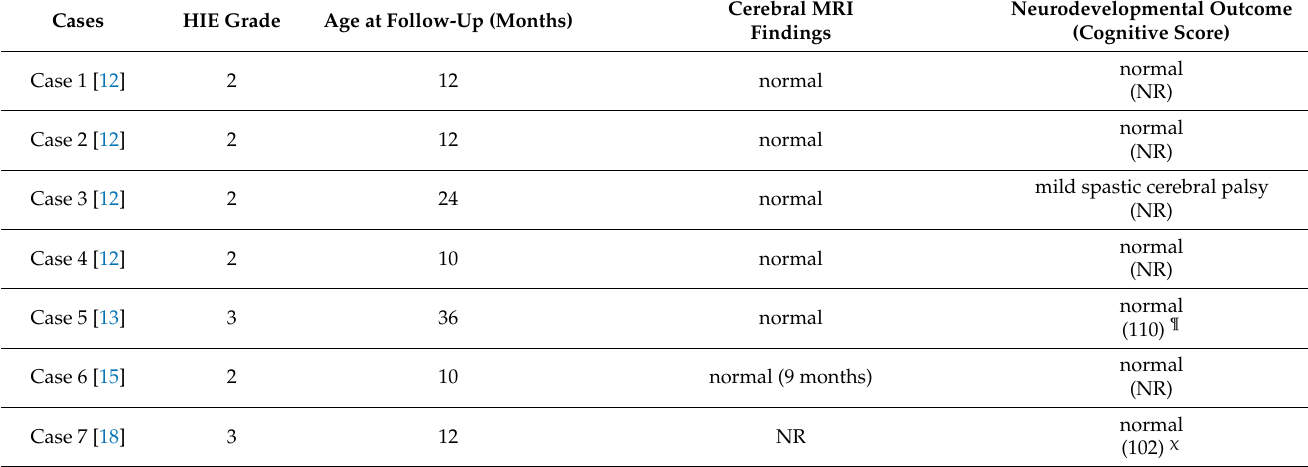
Table 3. Characteristics of infants with SUPC treated with TH and with complete neurodevelopmental follow-up, described in the